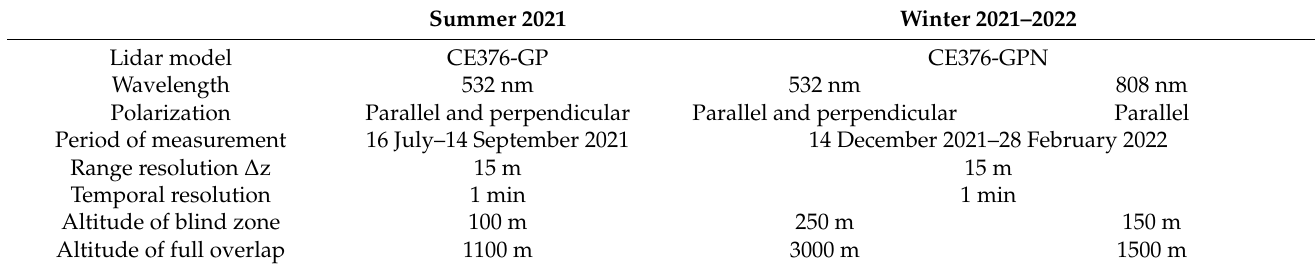
Table 1. Technical characteristics of the CE376 lidars depending on the measurement periods in Marseille.